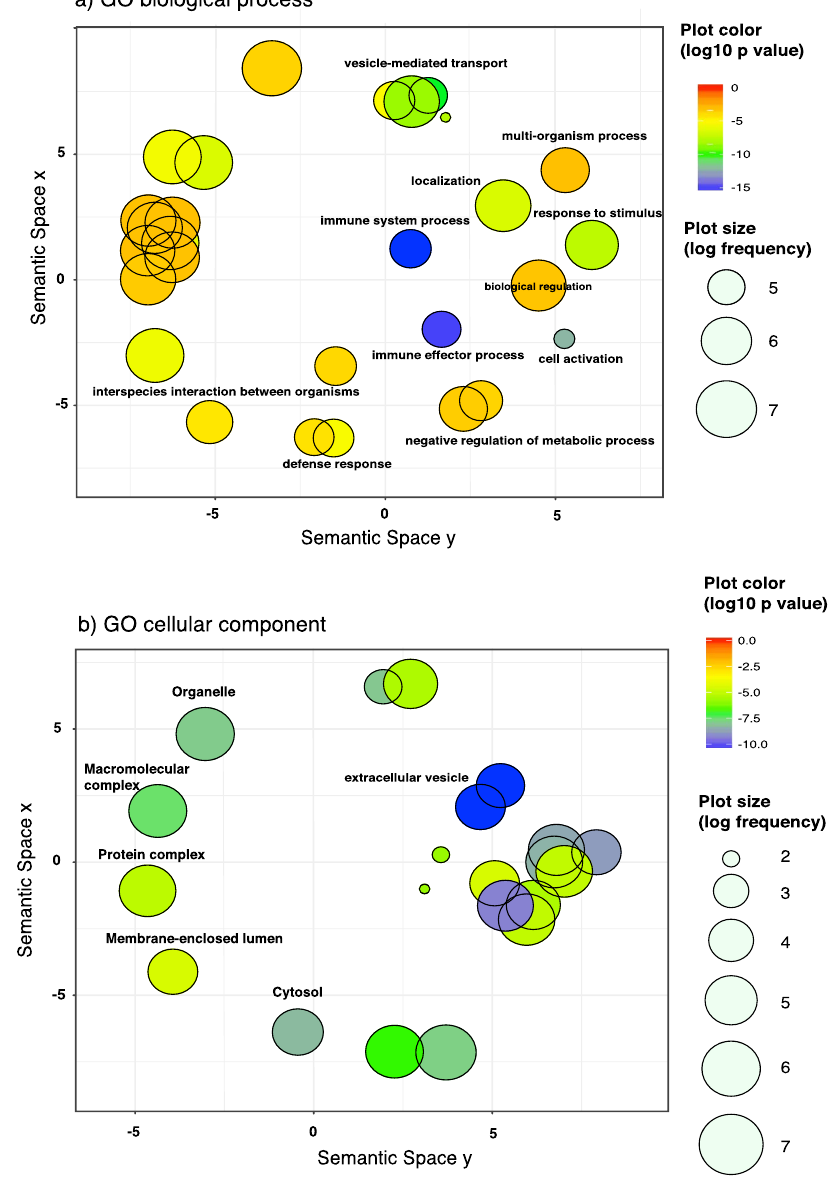
Figure 2. Gene ontology enrichment analysis. GO enrichment analysis of host (human) proteins was performed using GOrilla 16 and summarized and visualized as scatter plot using REvigo 17 . (Panel a) shows a scatter plot generated in REvigo with the “GO biological terms” clusters remaining after redundancy reduction. (Panel b) shows a scatter plot generated in REvigo with the “GO cellular components clusters” remaining after redundancy reduction. In REvigo the x and y coordinates are derived from a multidimensional scaling to a matrix of the GO terms semantic similarity 17 , in such a way that similar terms are located close in the plot. Only those terms with dispensability value equal 0.00 and p value < 0.001 are labelled. Plot colour indicates the enrichment log p value range and the plot size indicates the frequency of the GO term in the database. More general terms are showed with larger